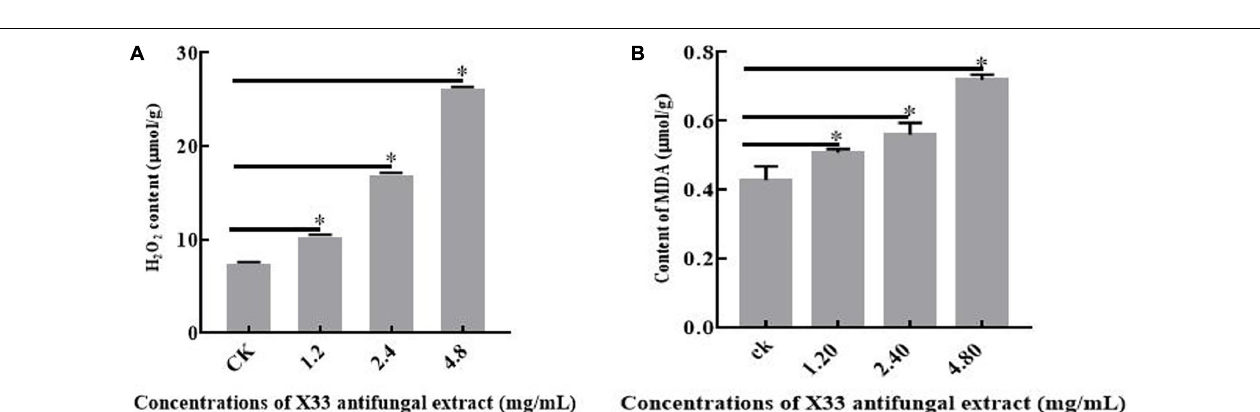
agents thymol (Perezalfonso et al., 2012), chitosan oligomers (Lu et al., 2014), clove essential oil (Chen et al., 2019a), and